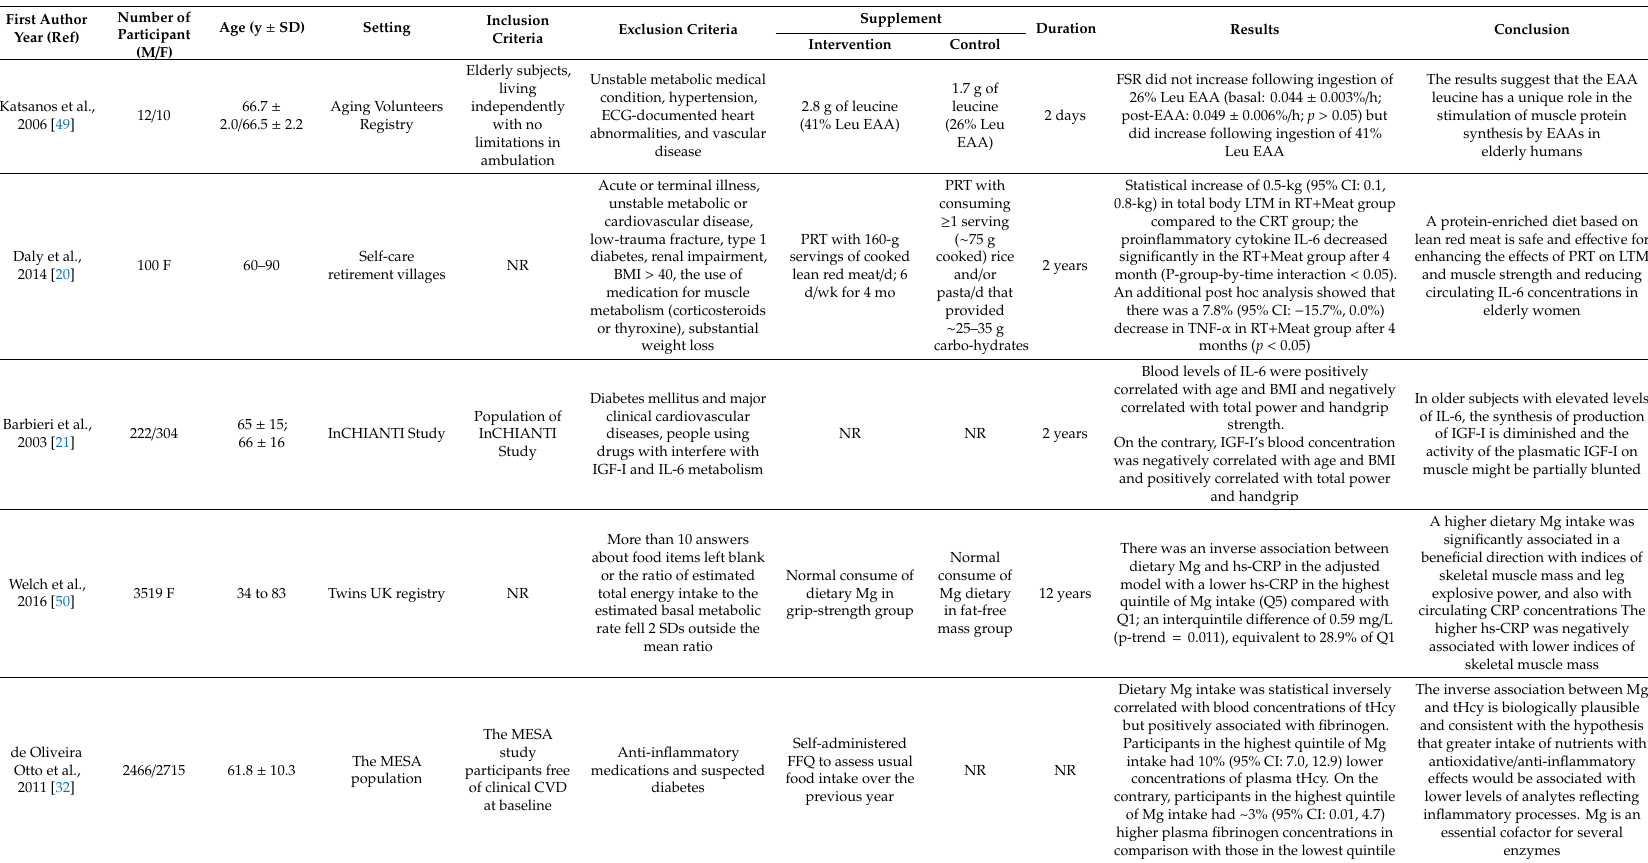
Table 2. Nutritional